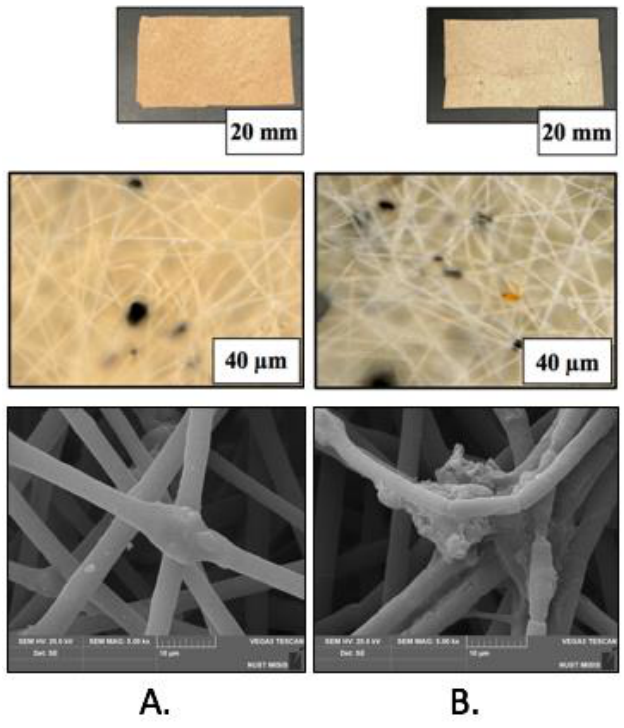
Figure 8. Snapshots and SEM images of the Hmi /PHB samples before ( A ) and after ( B ) outdoor exposure.